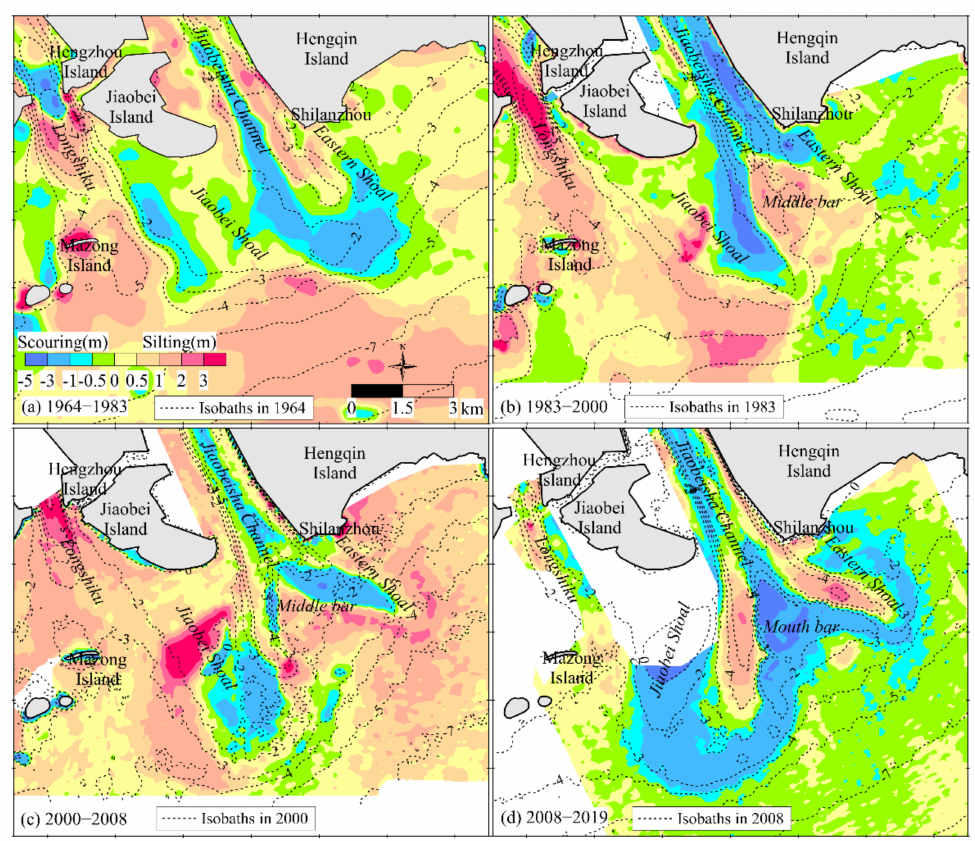
Figure 4. Planar maps of scouring and siltation in different decades. ( a ) from 1964 to 1983; ( b ) from 1983 to 2000; ( c ) from 2000 to 2008; ( d ) from 2009 to